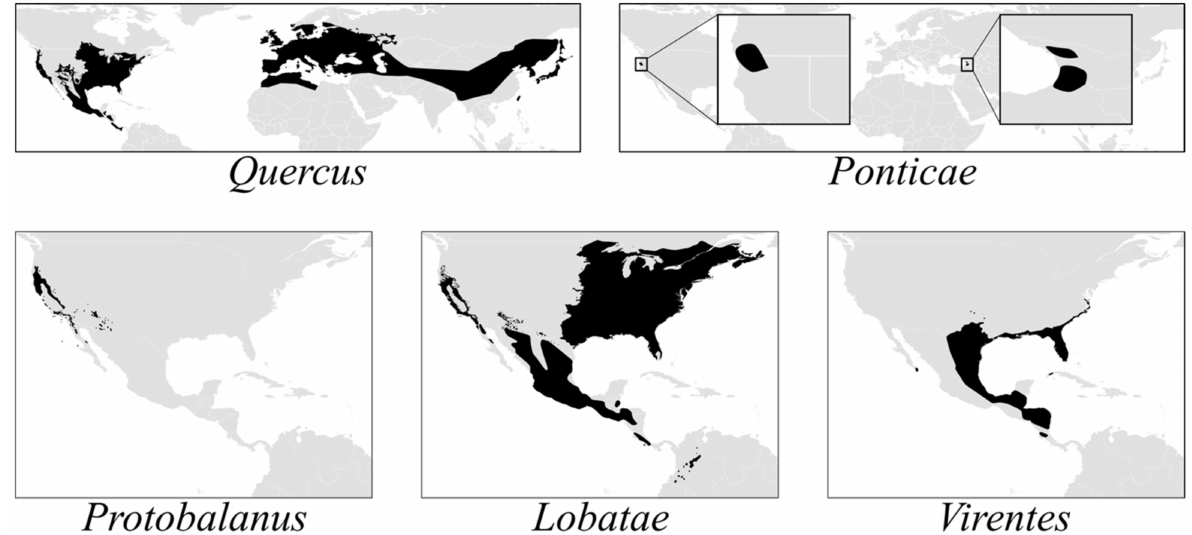
Figure 1. Distributions of the five oak sections of the American oak clade ( Quercus subg. Quercus ). Maps were generated using species maps provided by Little [31,32], as refined by recent studies [17] and herbarium